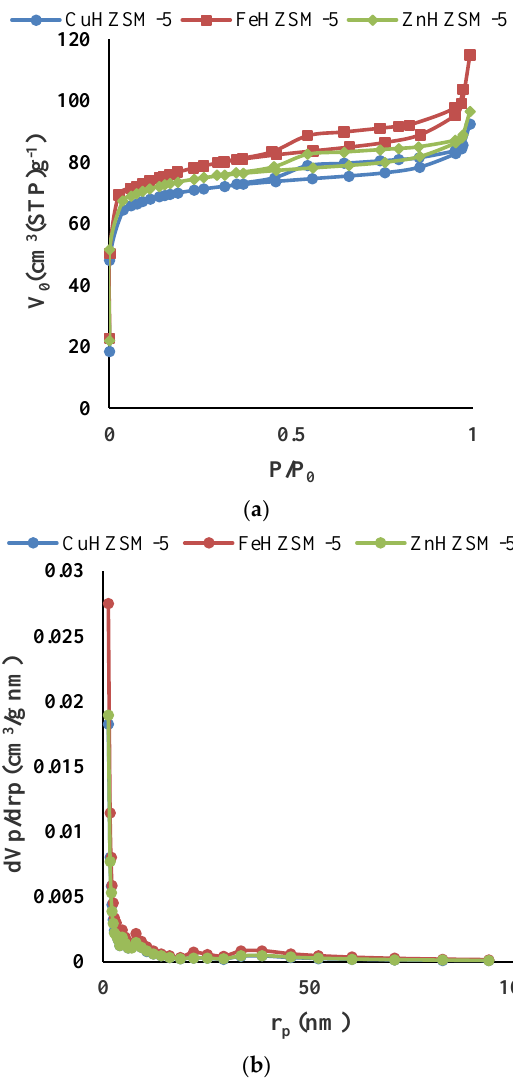
Figure 4. ( a ) N 2 adsorption, desorption for different catalysts 4 wt. % FeHZSM-5, 4 wt. % ZnHZSM-5 and 4 wt. % CuHZSM-5; ( b ) pore diameter distribution of 4 wt. %. FeHZSM-5, 4 wt. % CuHZSM-5 and 4 wt. % ZnHZSM-5 catalysts. Table 1. BET surface area and pore size analysis for all catalyst samples.